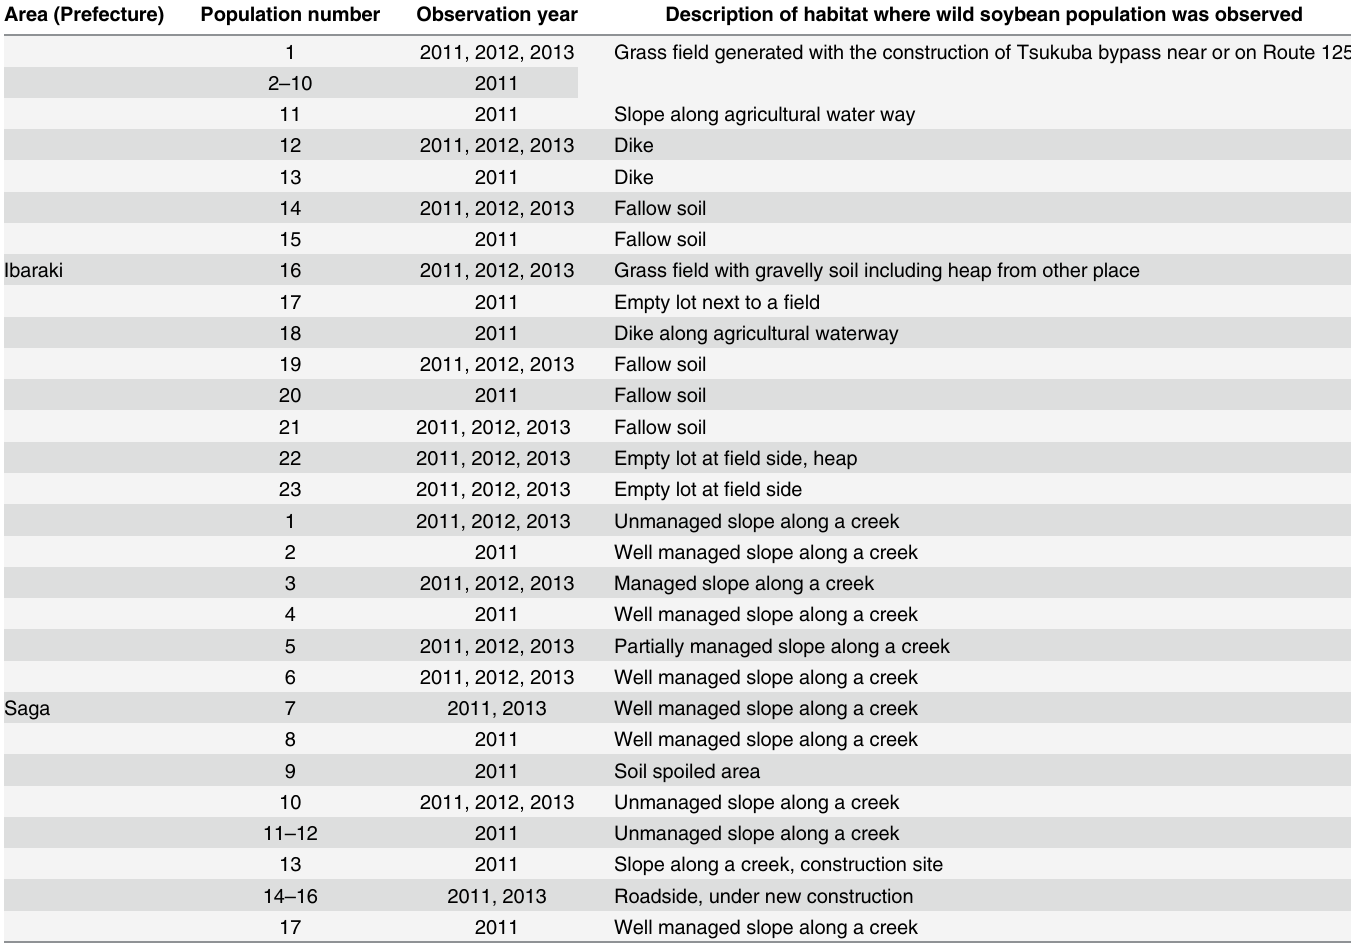
Table 1. Habitat for wild soybean populations observed in the surveys of insect leaf feeding damage in 2011, 2012 and 2013 in Japan. Area (Prefecture) Population number Observation year Description of habitat where wild soybean population was observed 1 2011, 2012, 2013 Grass fi eld generated with the construction of Tsukuba bypass near or on Route